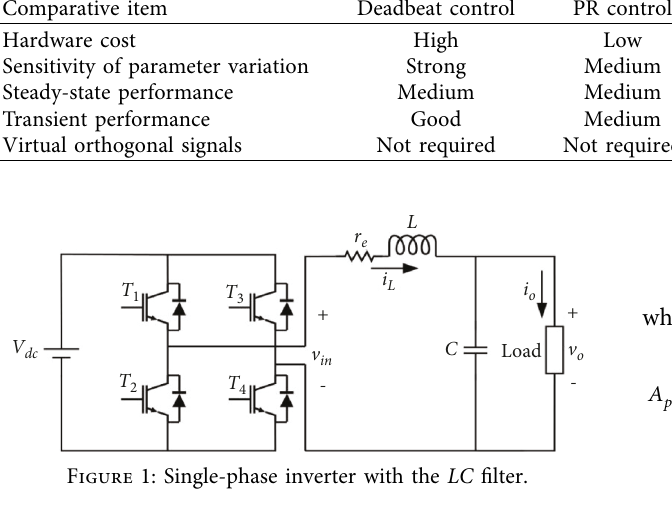
Figure 1: Single-phase inverter with the LC